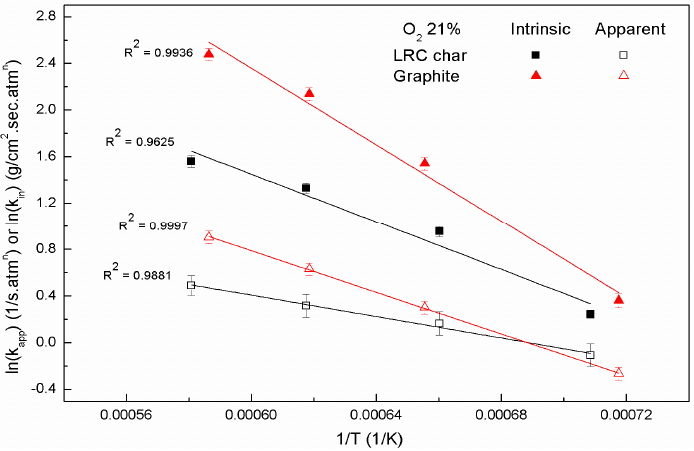
Figure 6. Comparison of reaction rate constants when considering oxygen diffusion at an ambient oxygen concentration of 21%.